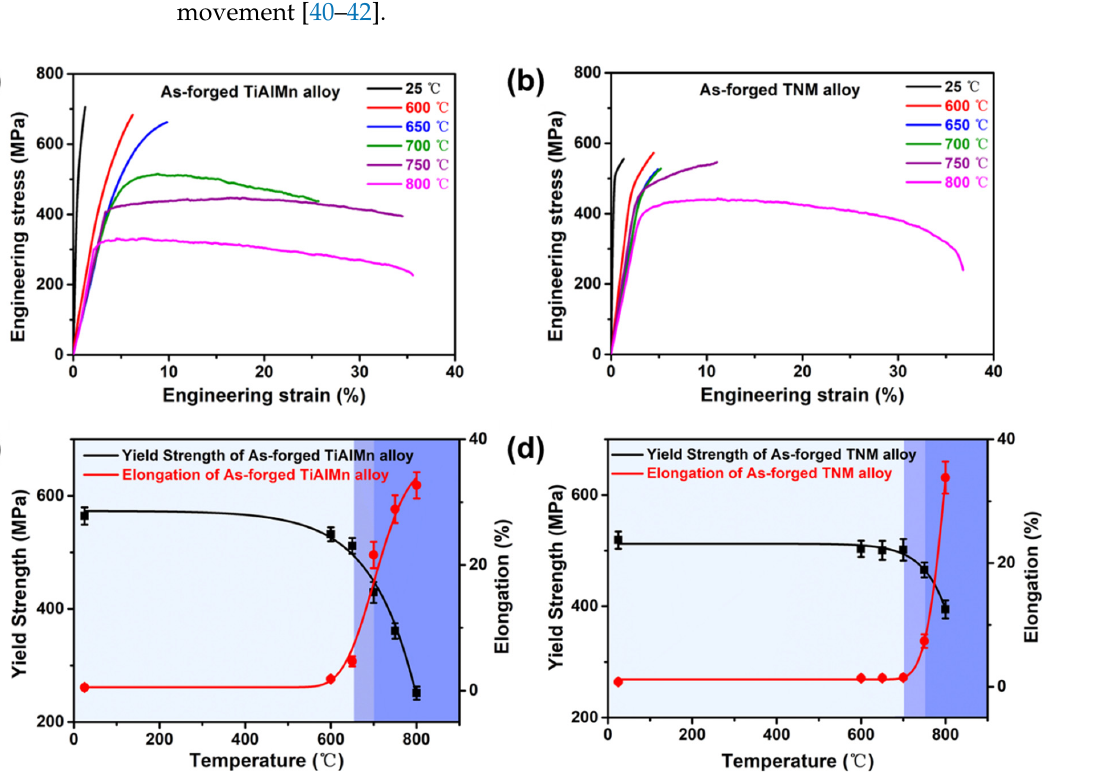
Figure 5. The tensile properties of as-forged TiAlMn alloy and TNM alloy: ( a , b ) the engineering stress–strain curves at different temperatures, ( a ) TiAlMn alloy, ( b ) TNM alloy; ( c , d ) the tensile properties as a function of the testing temperature, ( c ) TiAlMn alloy, ( d ) TNM alloy. The UTS, YS, and EL of as-forged TiAlMn alloy and TNM alloy at 25 ◦ C reach 706 MPa, 565 MPa, 0.5%, and 556 MPa, 519 MPa, 0.8%, respectively. The YS of as-forged